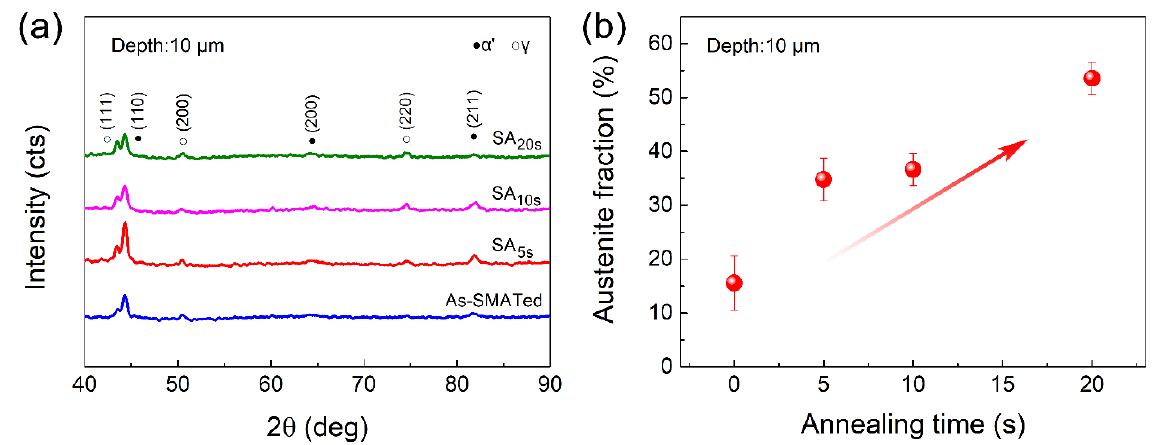
Figure 8. ( a ) XRD patterns obtained in the topmost surface layer of gradient samples after partial reverse transformation annealing. ( b ) The increase of austenite in the topmost surface layer with increasing annealing time.